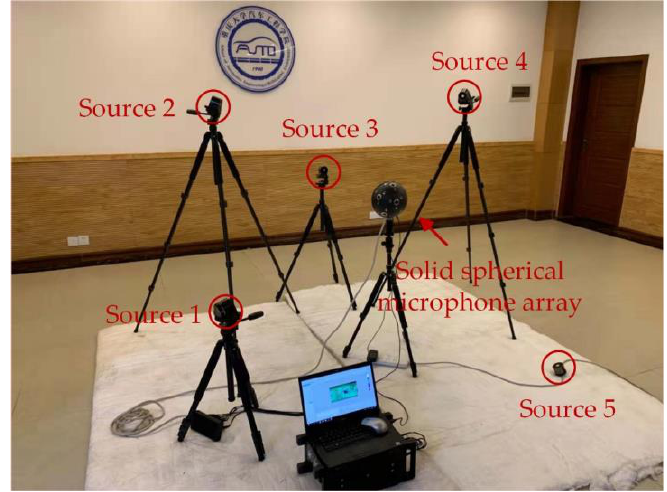
Figure 10. Experimental